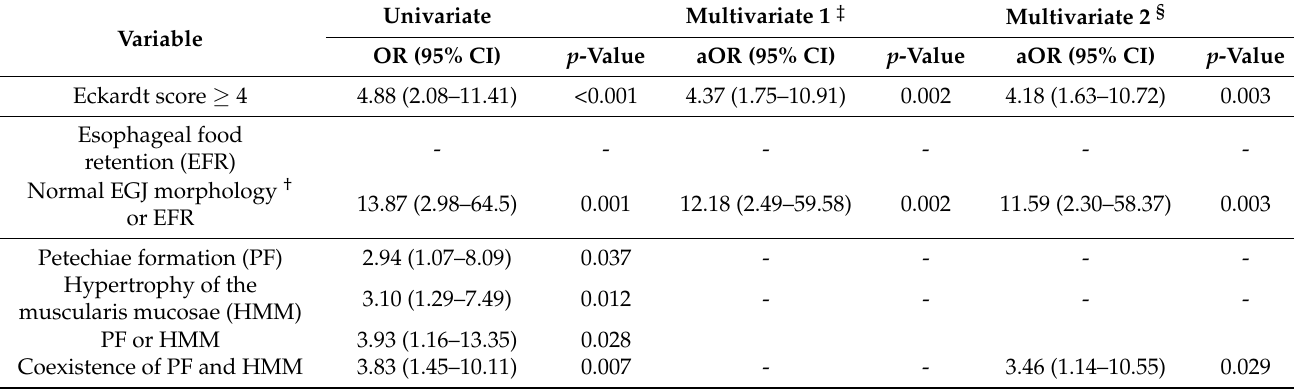
Table 4. Univariable and multivariable logistic regression analyses of achalasia